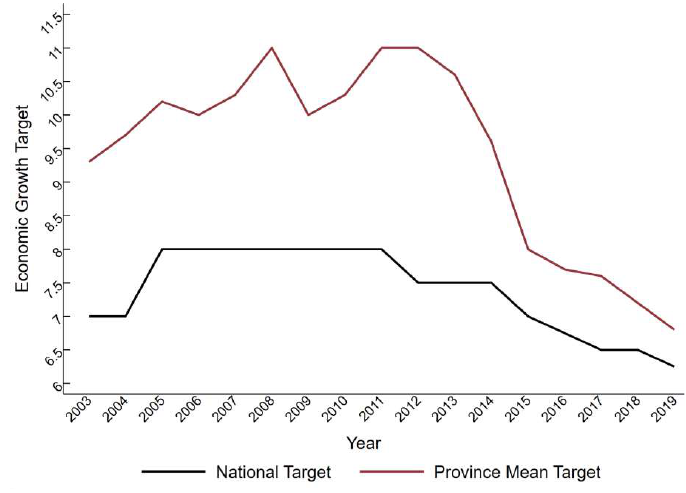
Figure 1. National EGT and provincial average EGT.